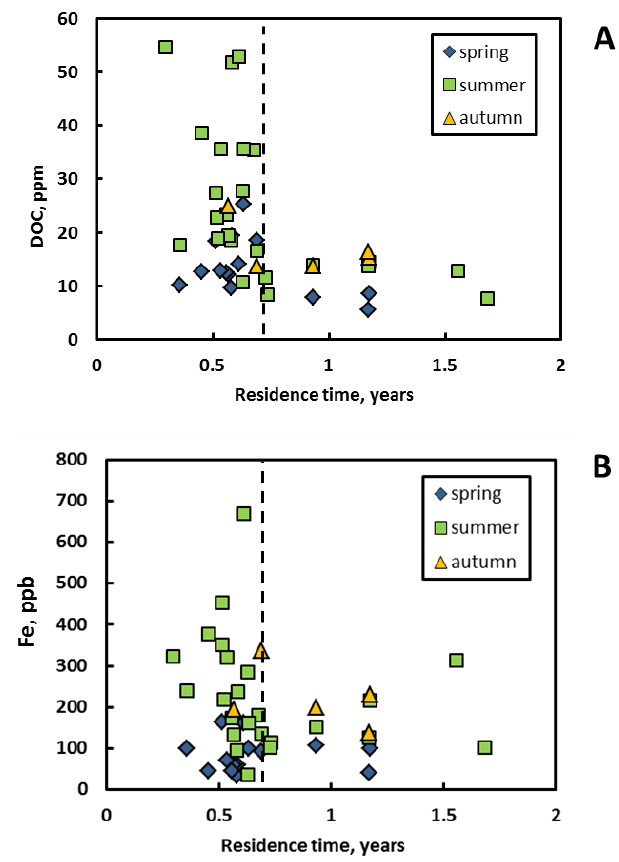
Figure 8. DOC (a) and Fe (b) concentrations during different sea- sons plotted as a function of water residence time in the water body. Vertical dashed line marks the beginning of concentration– residence time